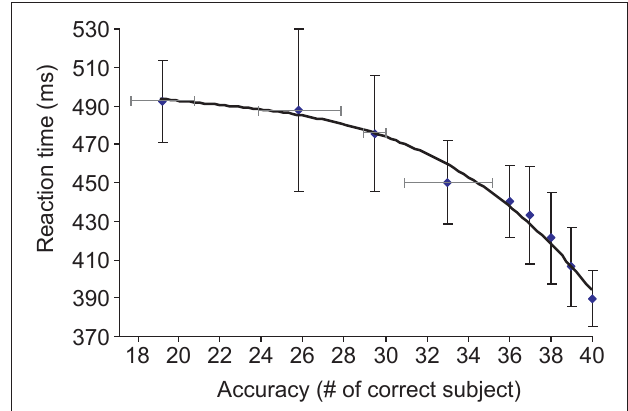
Figure 1 | global accuracy score plotted as a function of mean reaction time on target images. For each target image, we determined the mean reaction time (averaged over 40 subjects) and the accuracy in terms of the number of subjects that categorized the image correctly. More than half of the target-images (112 out of 200) were correctly categorized by all 40 subjects. Failure of a large number of subjects was only observed for a few target images. Vertical bars represent the standard deviation of reaction time on correctly categorized images. For lower accuracy levels ( < 35 subjects correct out of 40), reaction times were averaged for image clusters of approximately the same size. Four clusters were considered at accuracy levels corresponding to 19, 26, 29, and 33 (number of correct subjects out of 40 subjects), the horizontal bars representing the standard deviation in terms of subjects correct for these clusters. The correlation between accuracy and RT fits to an exponentially decreasing curve as shown above (linear correlation in appropriate log-space R 2 = 0.96; p < 2.10 − 7 ). For accuracy levels above or equal to 36/40, the relation between accuracy and RT is also close to linear ( R 2 = 0.98; p =